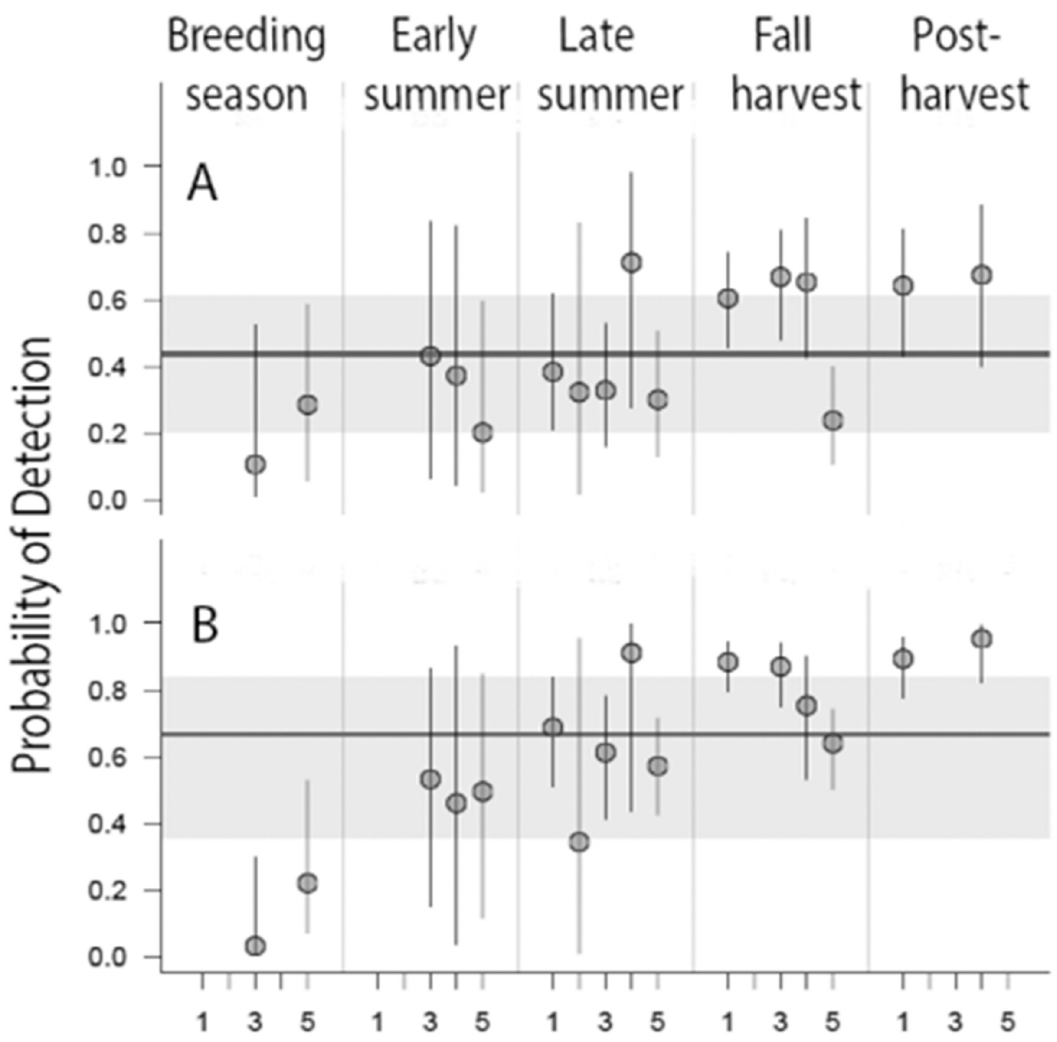
Fig 2. Posterior mean year-stage detection probabilities (red circles) and 95% Bayesian Credible Intervals (BCI; vertical black lines) of the (A) � 100 m radius, and (B) infinite radius data. Year-stage parameters are random effects from a hyper-distribution represented by the blue horizontal line (the posterior mean of the mean), the blue shaded area represents the 95% BCI of the estimate mean. Numbers 1–5 represent